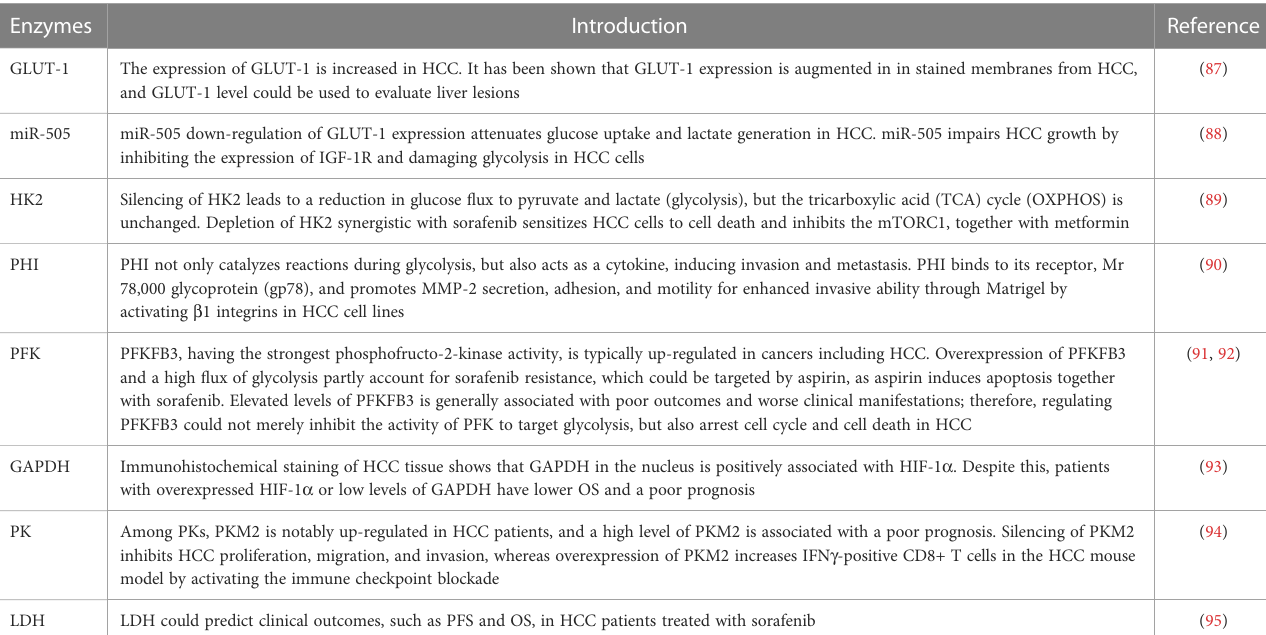
TABLE 2 Enzymes of glycolysis in HCC, their functions, and their impacts on therapy.